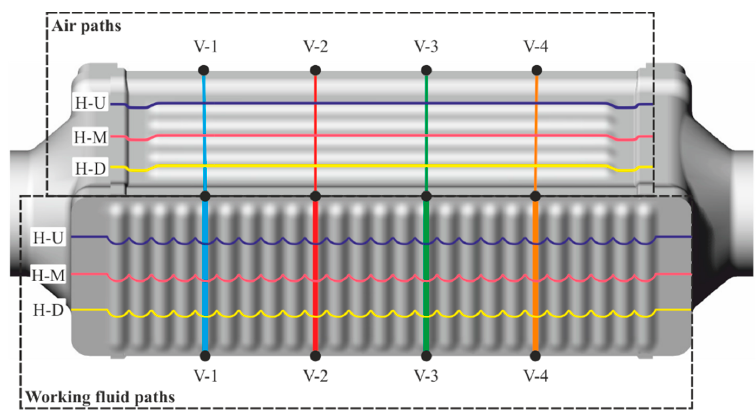
Figure 9. Definition and nomenclature of the paths studied.